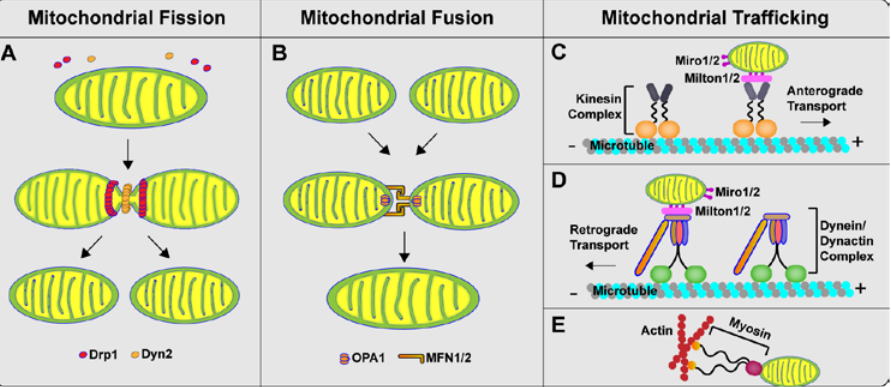
Figure 1. Schematic depiction of mitochondrial dynamics in mammalian cells. ( A ) Cytosolic Drp1 is recruited to the mitochondrial outer membrane by several receptor proteins, followed by oligomerization into ring-like structures to partially constrict the mitochondrial membrane. Then, another dynamin-like protein, dynamin 2 (Dyn2), binds and constricts the mitochondrial membrane further to enable lipid fusion and organelle division; ( B ) The mitochondrial fusion process requires two steps, outer membrane fusion and inner membrane fusion. Outer membrane fusion is mediated through interactions of coiled-coil domains of Mfn1 and Mfn2 to form either homo-oligomeric or hetero-oligomeric complexes to tether membranes together. OPA1 is involved in the formation of cristae junctions as well as in inner membrane fusion; ( C , D ) The anterograde motor kinesin-1 and the retrograde motor dynein/dynactin complex directly interact with Milton and Miro on mitochondria to drive their movement along the microtubules; ( E ) Actin motors are associated with mitochondria to facilitate the short-distant movement along the filament.